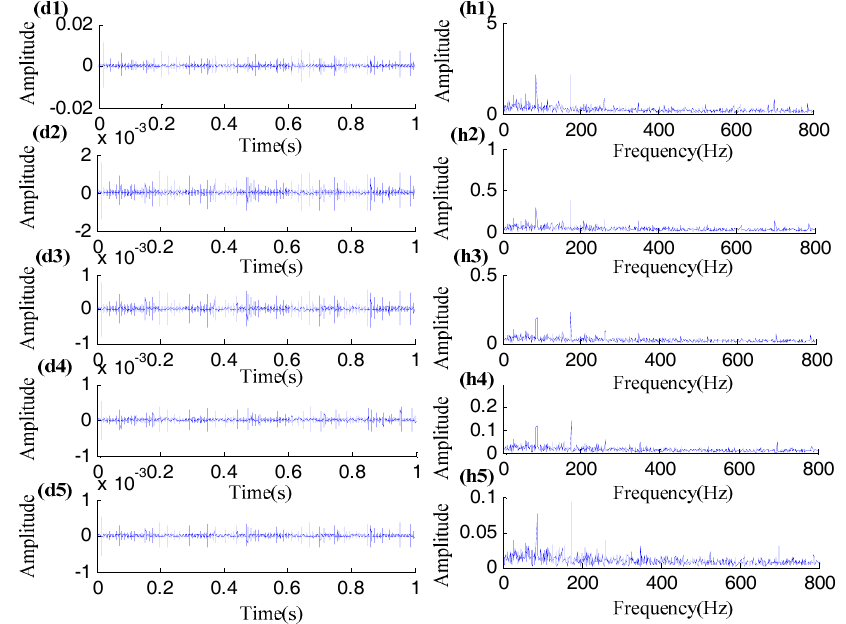
Figure 13. Time domain waveform of the five detail signals with the maximum kurtosis value and their corresponding Hilbert envelope demodulation spectrum. ( d1 – d5 ) The five detail signals with maximum kurtosis values obtained using MRSVD decomposition. ( h1 – h5 ) The corresponding Hilbert envelope demodulation spectrums of the five detail signals in ( d1 – d5 ).